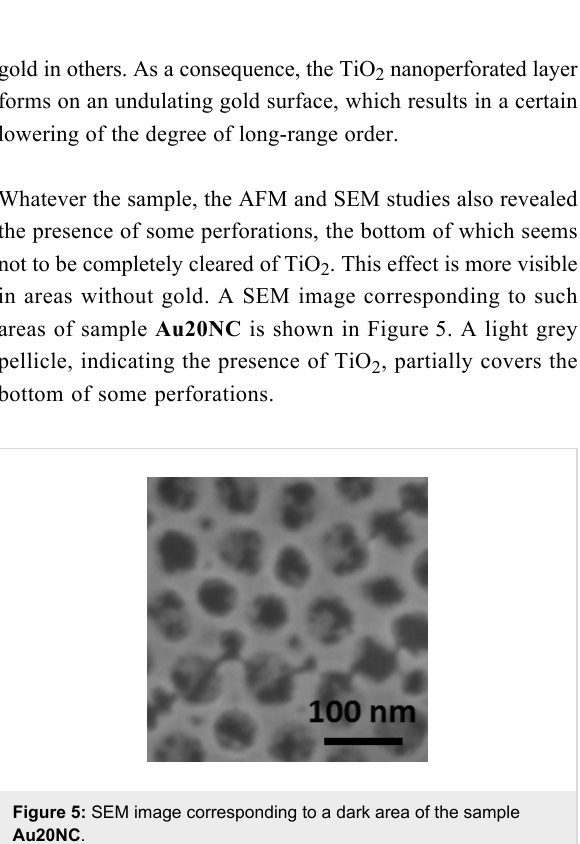
Figure 5: SEM image corresponding to a dark area of the sample Au20NC . The non-homogeneous and non-planar surface exhibiting a different chemical nature of the bottom of the nanoperforations of the films deposited on a 10 nm thick gold layer, such as sample Au10NC , can be assigned to a dewetting of the gold layer from the silicon during the thermal treatment at 450 °C.